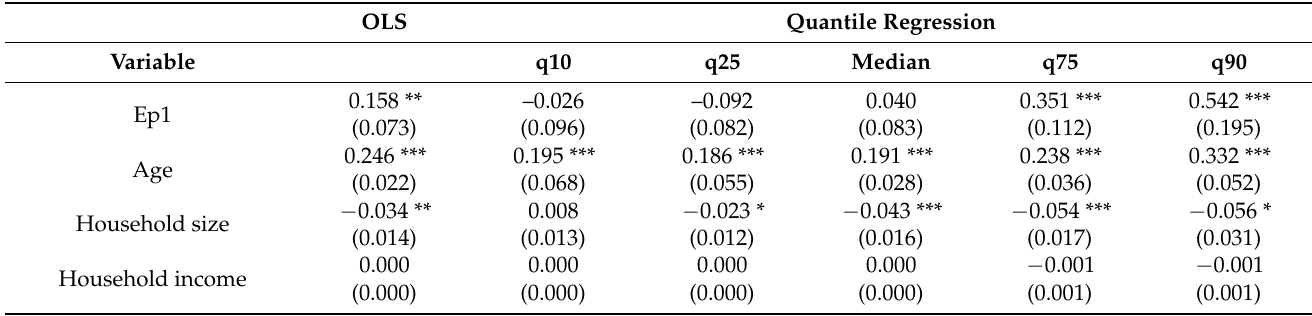
Table 2. Estimated parameter coefficients from the OLS and quantile regression models with EP1 as energy poverty